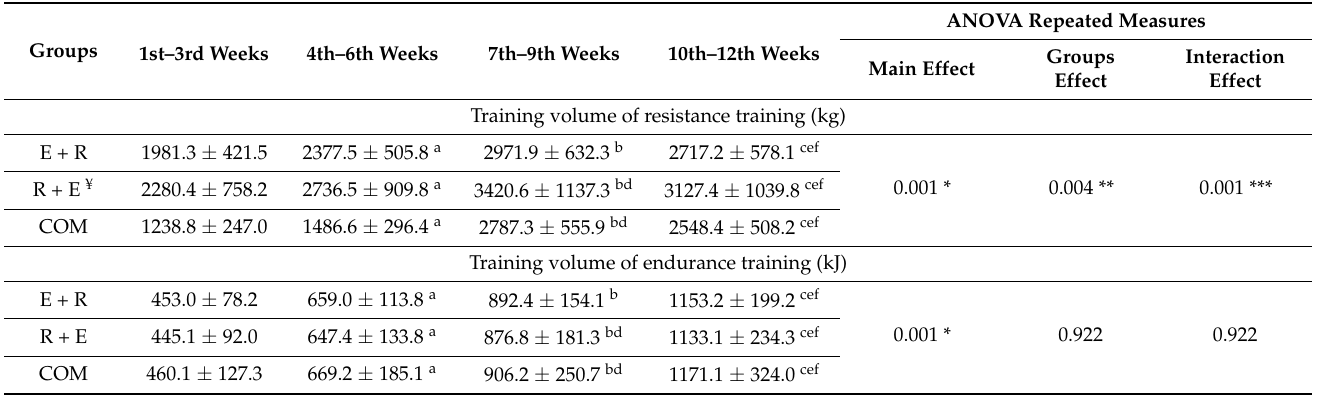
Table 3. Training volume of resistance and endurance training in three intervention